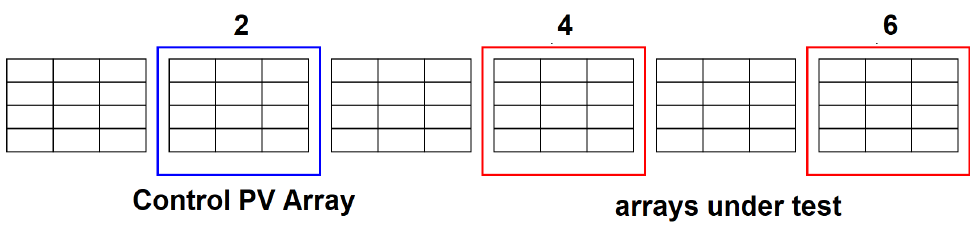
Figure 4. Diagram of the analyzed PV installation. The monocrystalline PV arrays 2, 4 and 6 were used in this